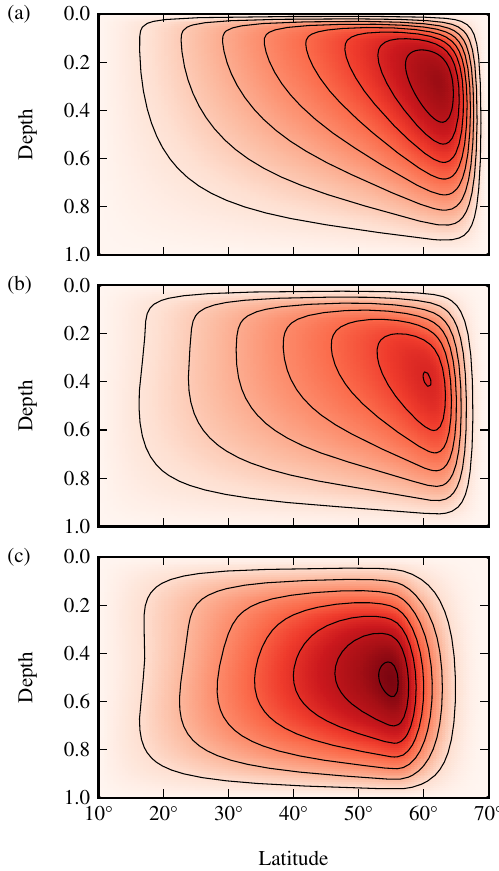
Fig. 5. Buoyancy fields of the standard solution: (a) western- boundary buoyancy b w (contour interval 0 . 5 × 10 − 2 ms − 2 ), (b) eastern-boundary buoyancy b e (contour interval 0 . 5 × 10 − 2 ms − 2 ), and (c) east-west buoyancy difference b e − b w (con- tour interval 0 . 1 × 10 − 2 ms − 2 ).